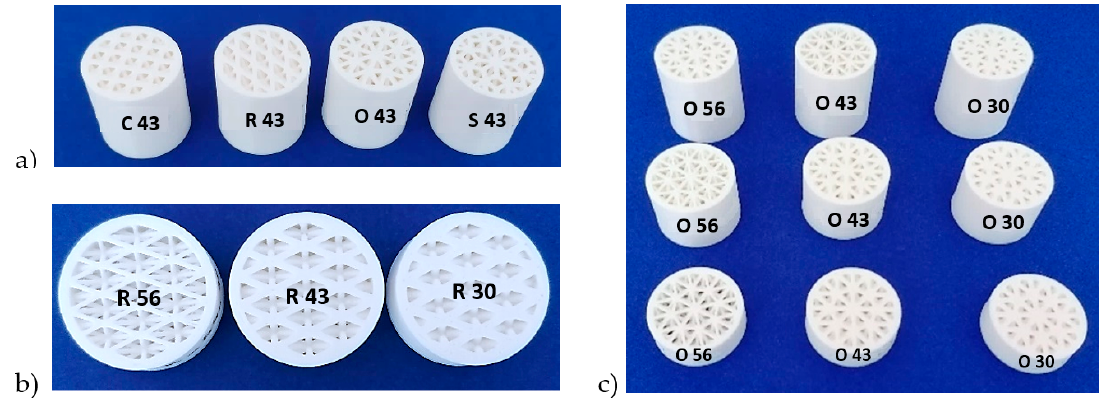
Figure 2. Examples of samples produced. ( a ) samples of thickness t = 30 mm and volume porosity P = 43% with different types of structure, ( b ) rhomboid samples with different volume porosities and ( c ) a set of samples with octagonal structure. (Note: the numbers on the sample labels in the figure indicate the total volume porosity in %).